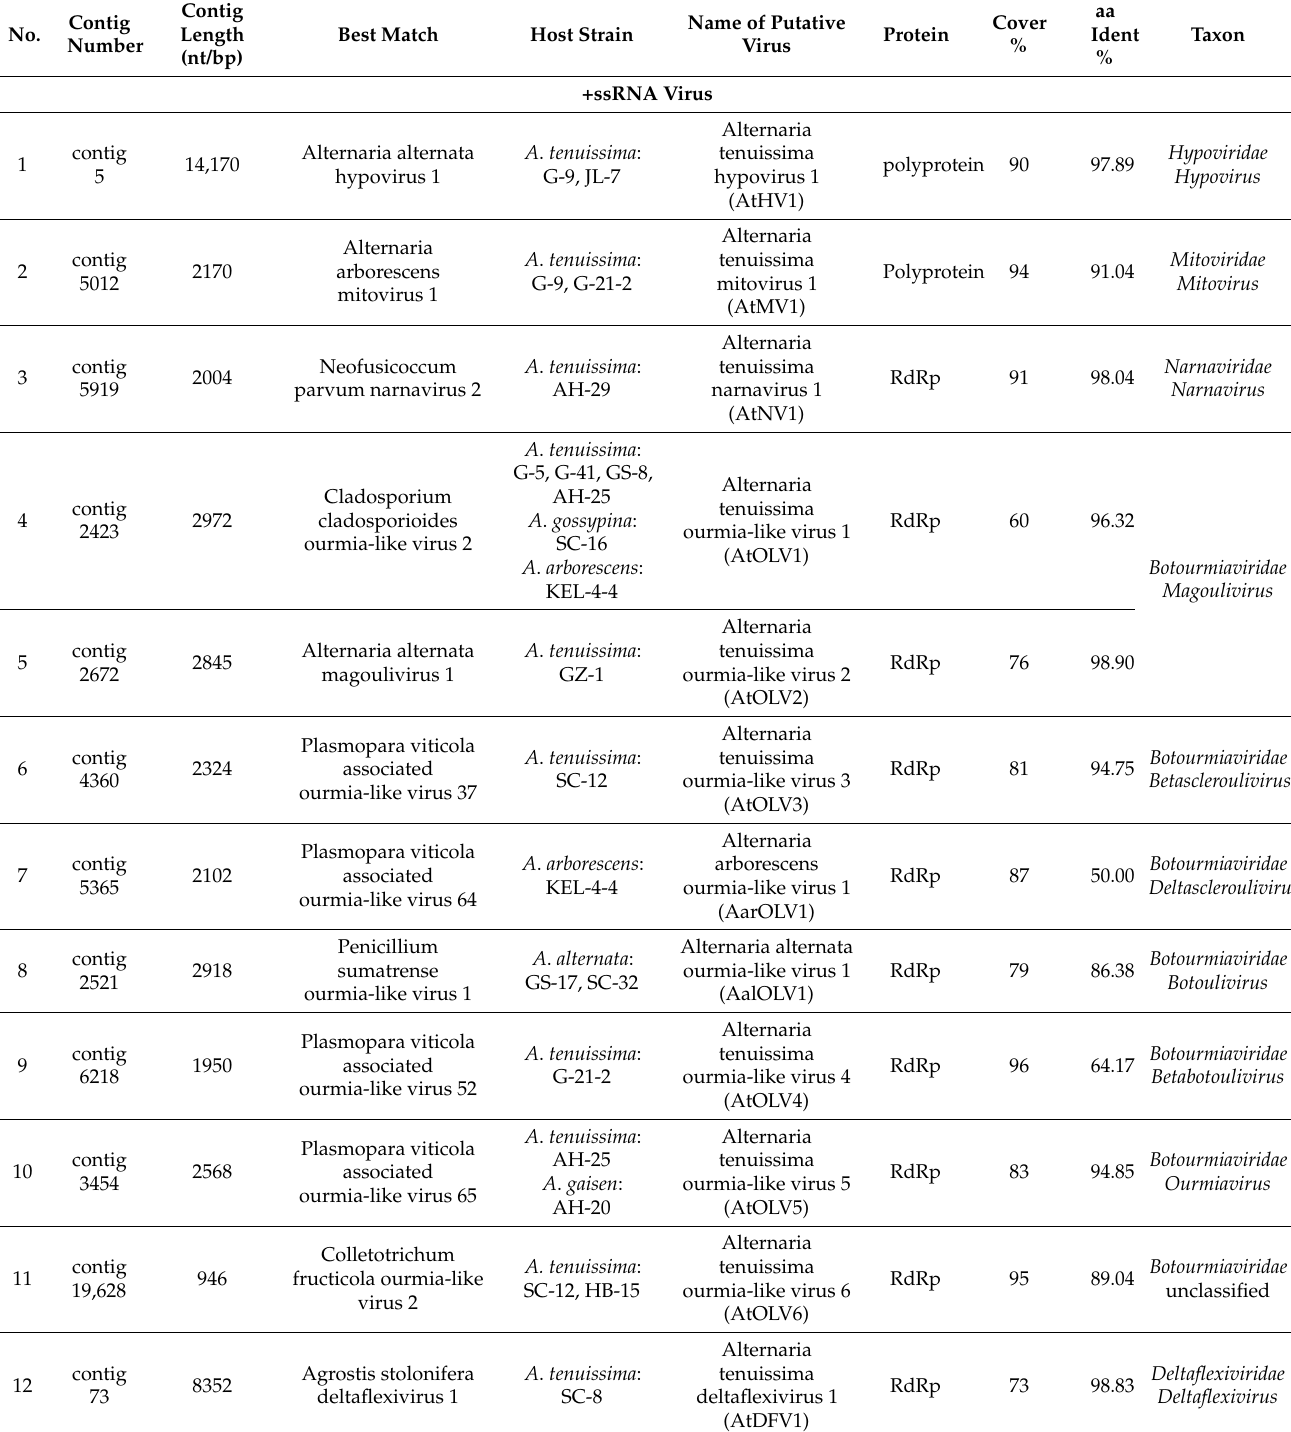
Table 2. Best BLASTx matches of contigs obtained in this